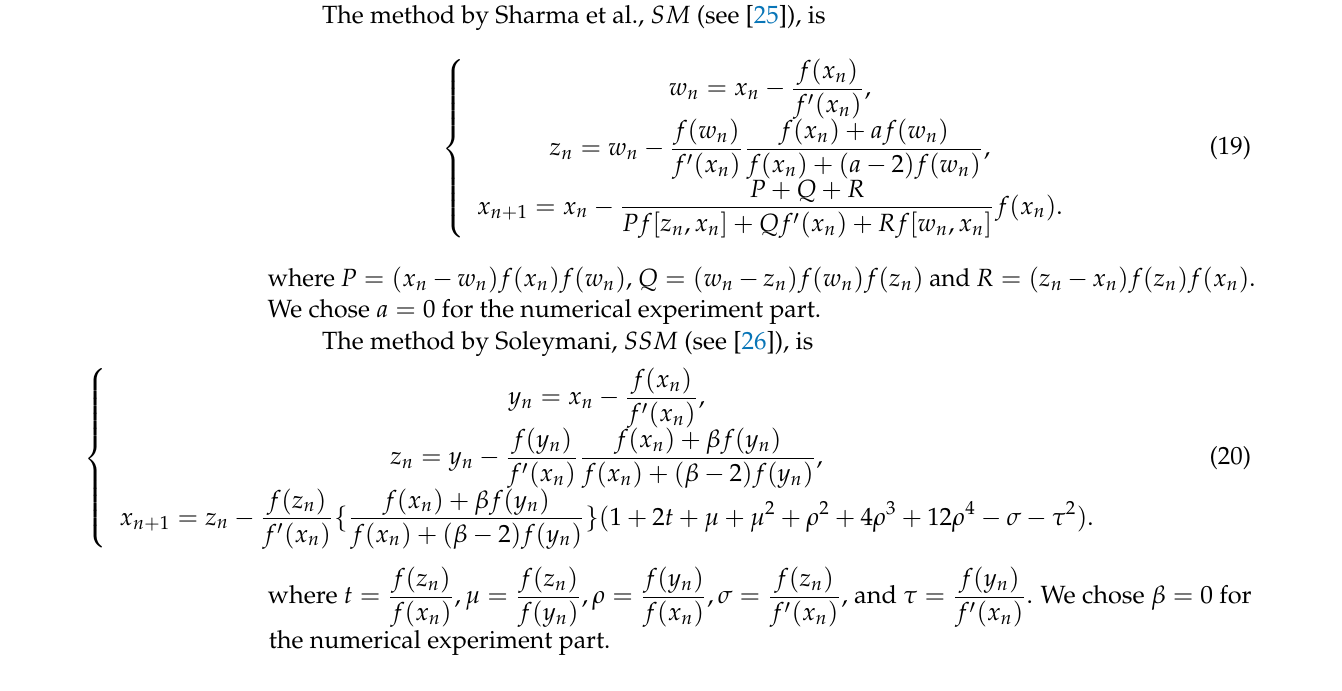
Table 4. Comparison of iterative methods for H 1 ( V ) =